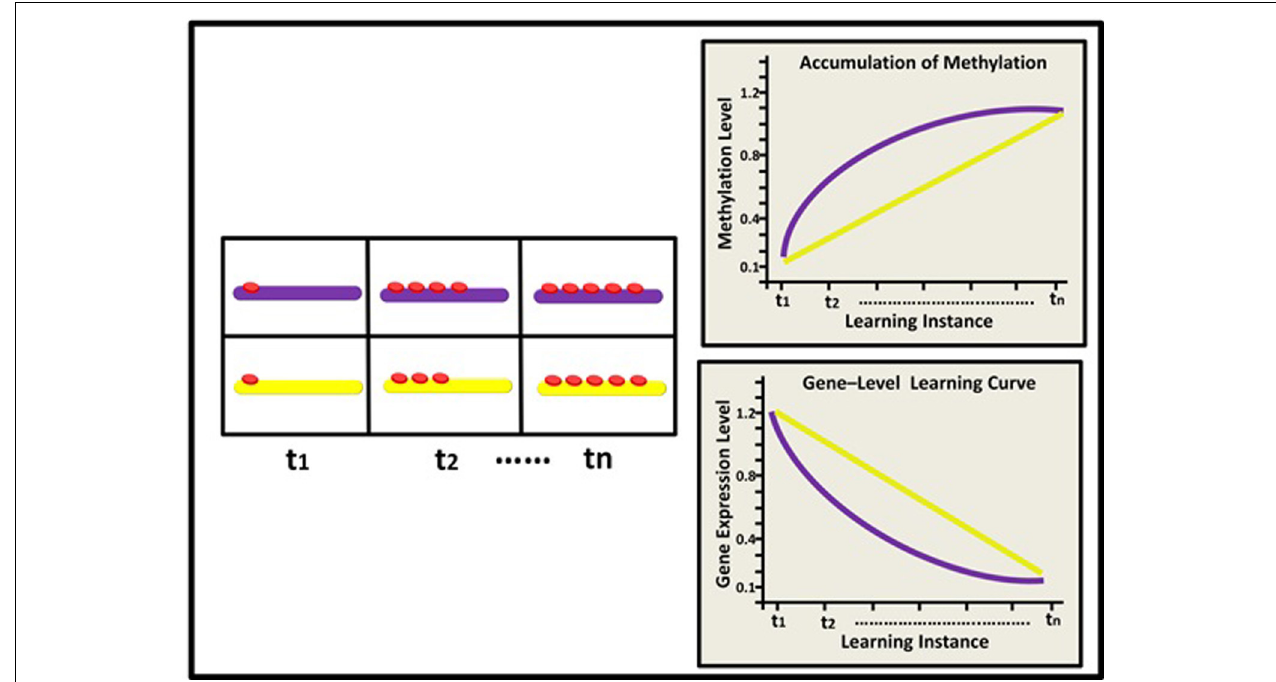
FIGURE 2 | Epigenetic dynamics during learning can shape the neural learning-curve at the single gene level: Initially (t1), two learning-suppressing gene promoters (purple and yellow rods) have similar basal methylation level (red buttons). During learning, (t2–tn) these two genes exhibit different patterns of epigenetic change and subsequently,